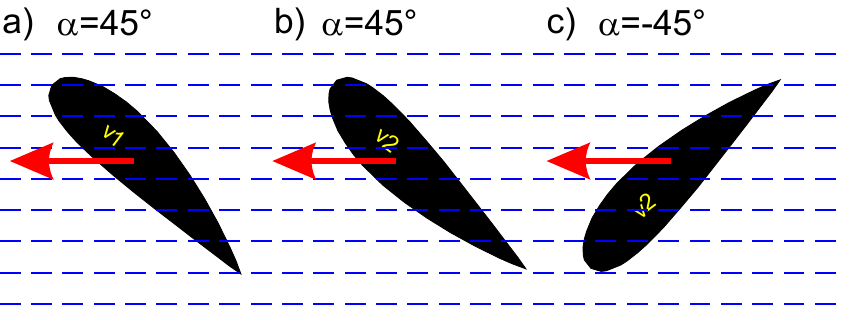
Figure 4. Positioning of asymmetrical profile. ( a ) normal profile setting as in airplane wing ( b ) reverse positioning of the profile (upside down) ( c ) setting equivalent to setting ( b ).